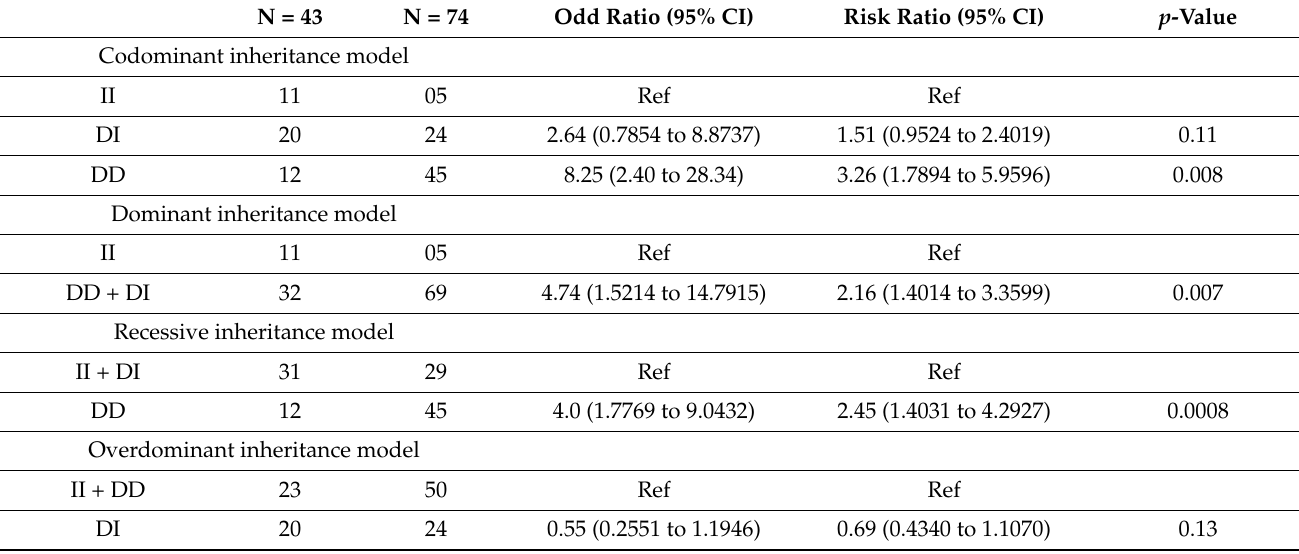
Table 7. Statistical comparisons ( p -values) of ACE2-rs4646994 I/D genotypes with mortality of COVID-19 patients. N =